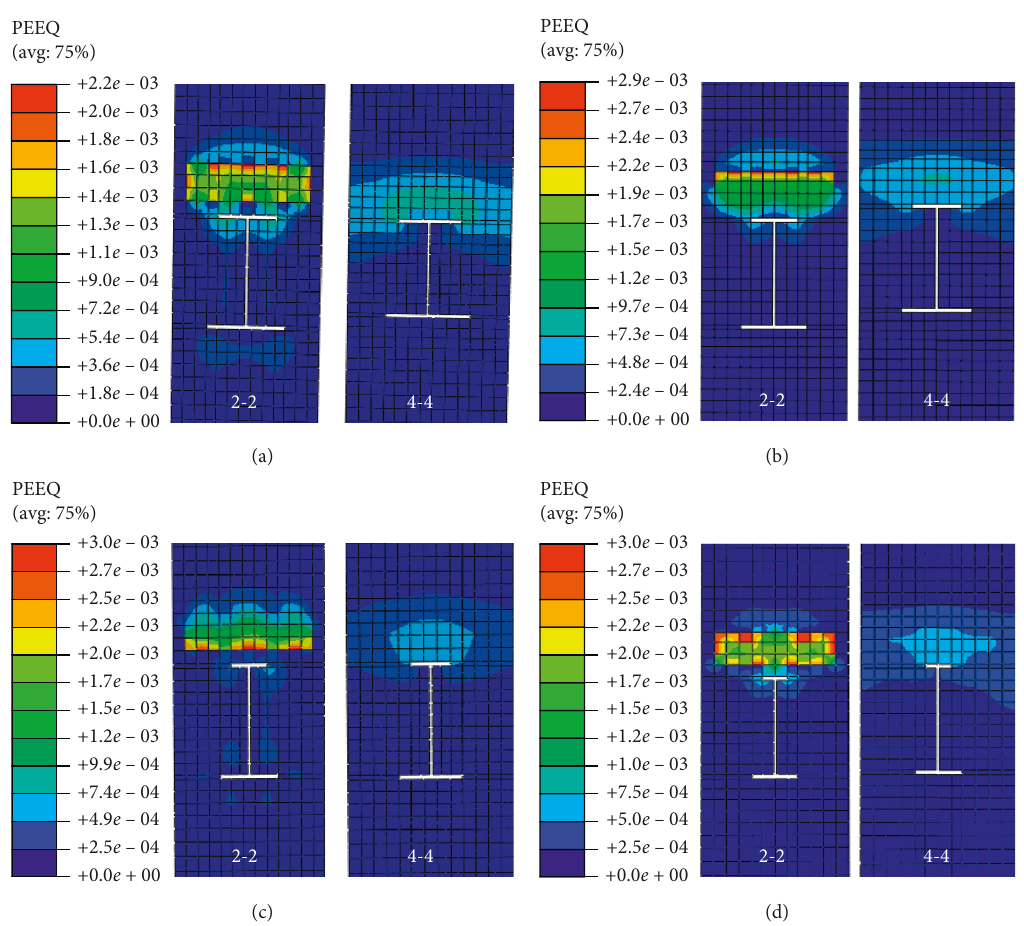
Figure 12: Equivalent plastic strain (PEEQ) of core concrete for (a) CFCJ1, (b) CFCJ2, (c) CFCJ3, and (d)